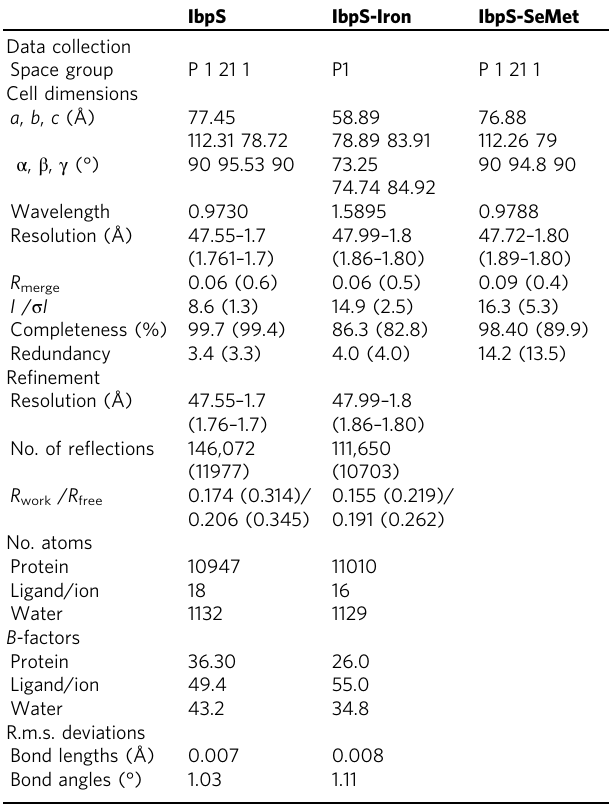
Table 1 Data collection and re fi nement